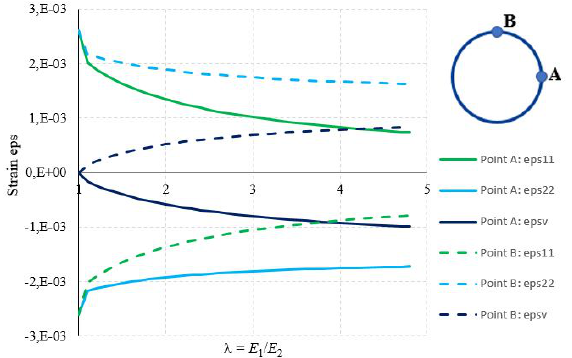
Fig. 4. Pore pressure on line AA ′